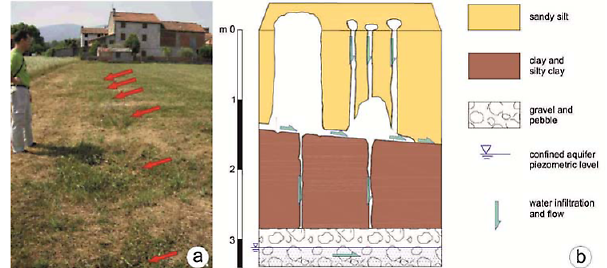
Fig. 15. (a) Swarm of filled sinkhole-like features N–S-oriented (the cavities are recognizable by more green grass, due to greater moisture). (b) Sketch of sinkhole-like features connected by sub- horizontal or lightly sloping tunnels.